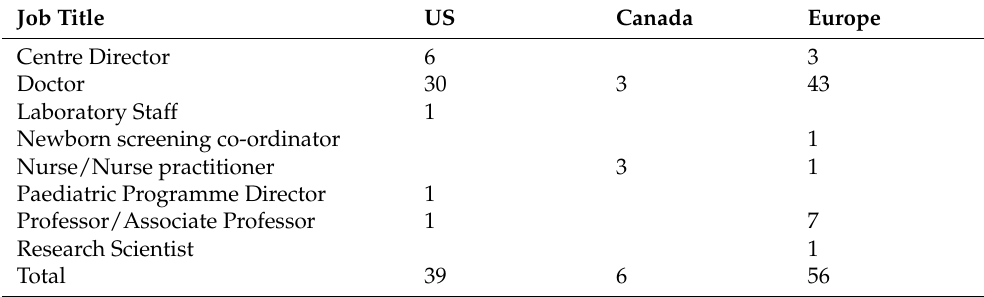
Table 1. Job title of study participants.